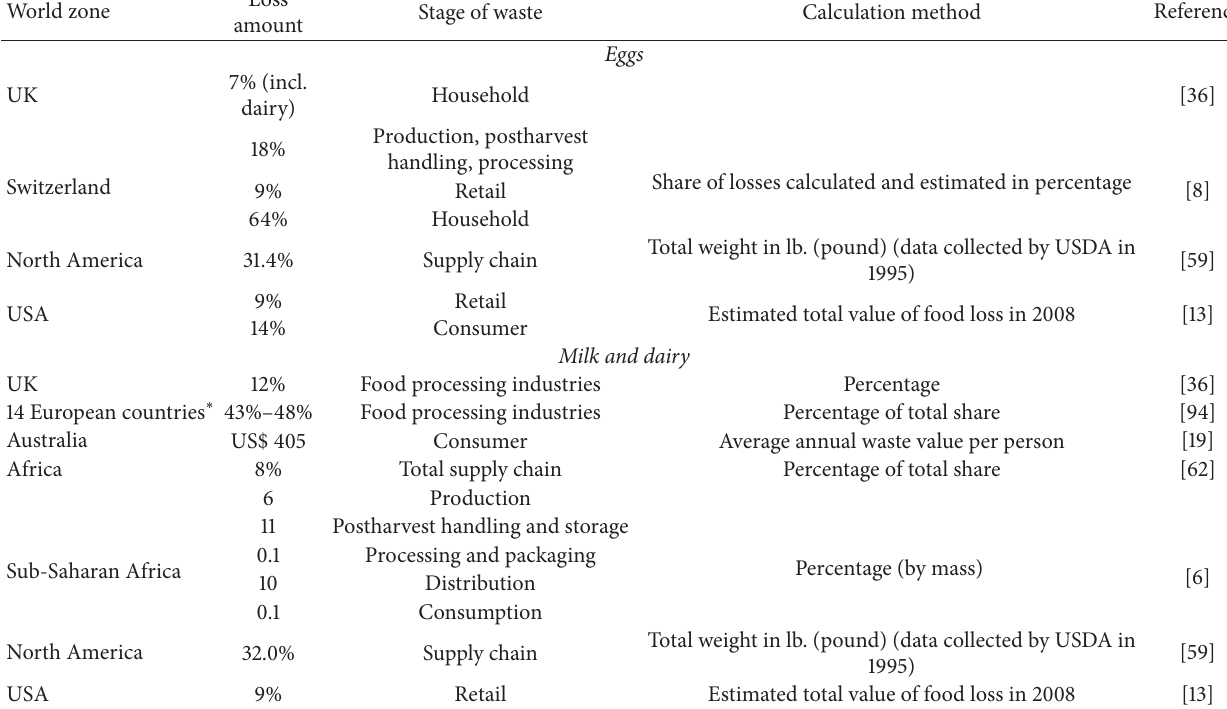
Table 7: Amount/percent/value of eggs, milk, and dairy waste in the world food supply